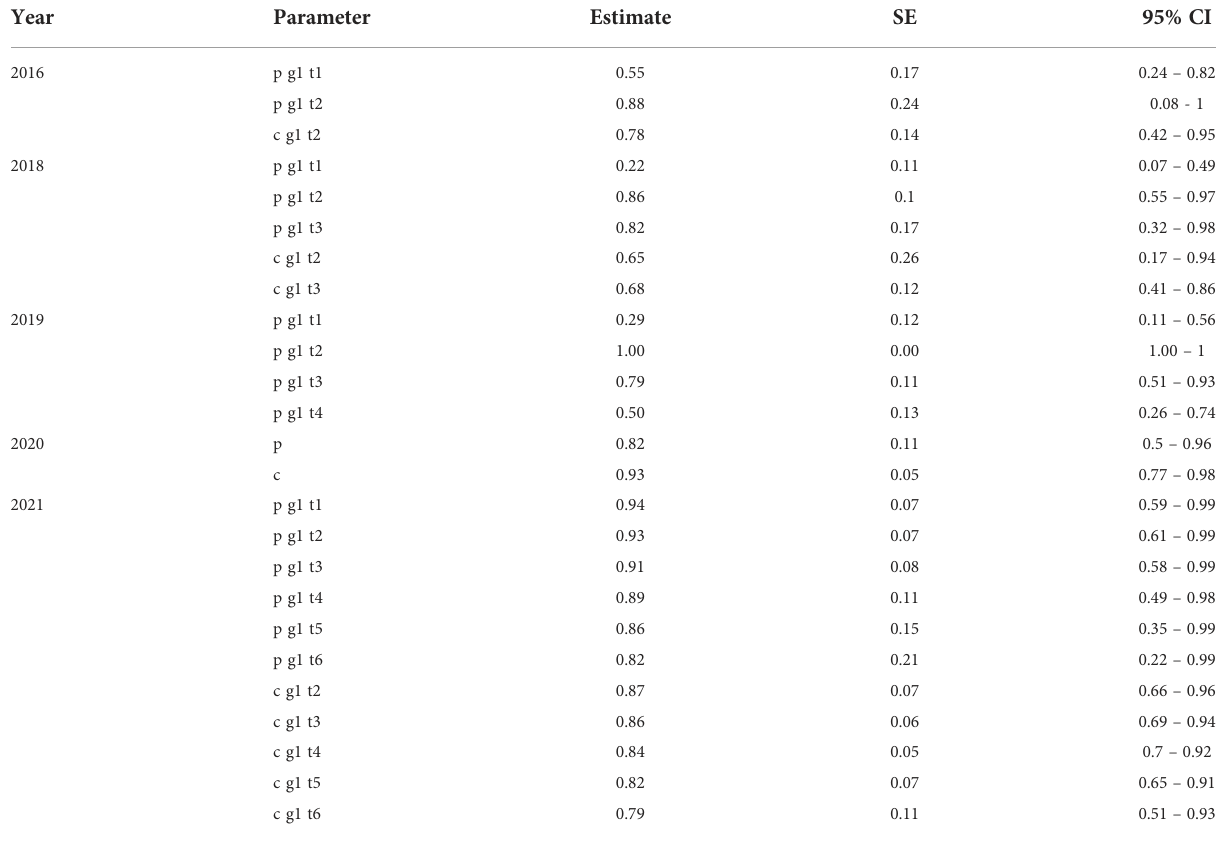
TABLE 5 Averaged parameters of the closed population models applied to each